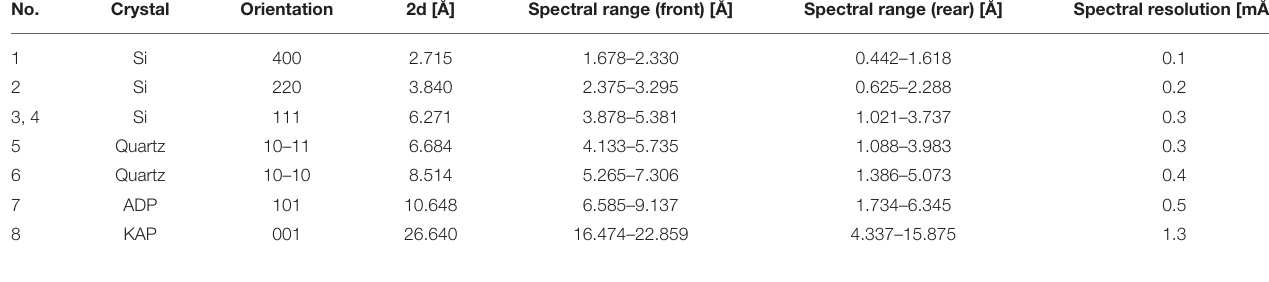
TABLE 5 | Parameters of crystals used in rotating-drum spectrometer (RDS) and corresponding spectral ranges: “front” and “rear” refer to wavelength bands covered by front and rear pairs of detectors. No.